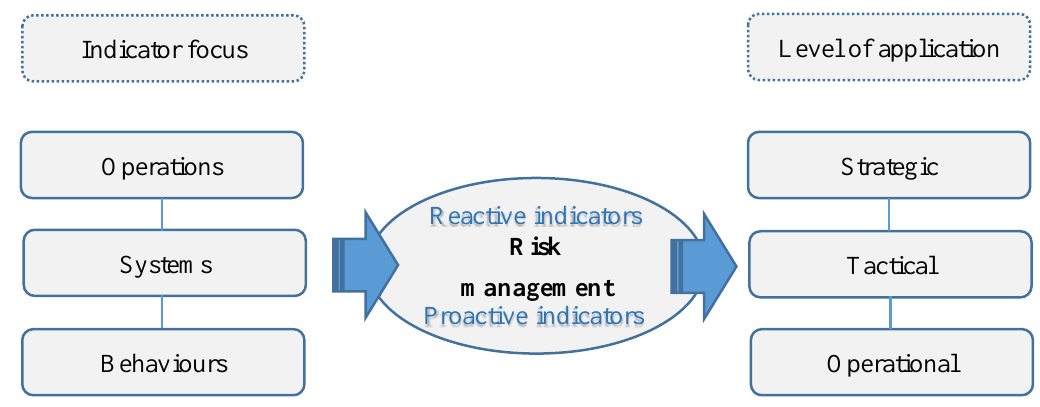
Figure 5. Focus and levels of application of indicators used for measuring risk management maturity.